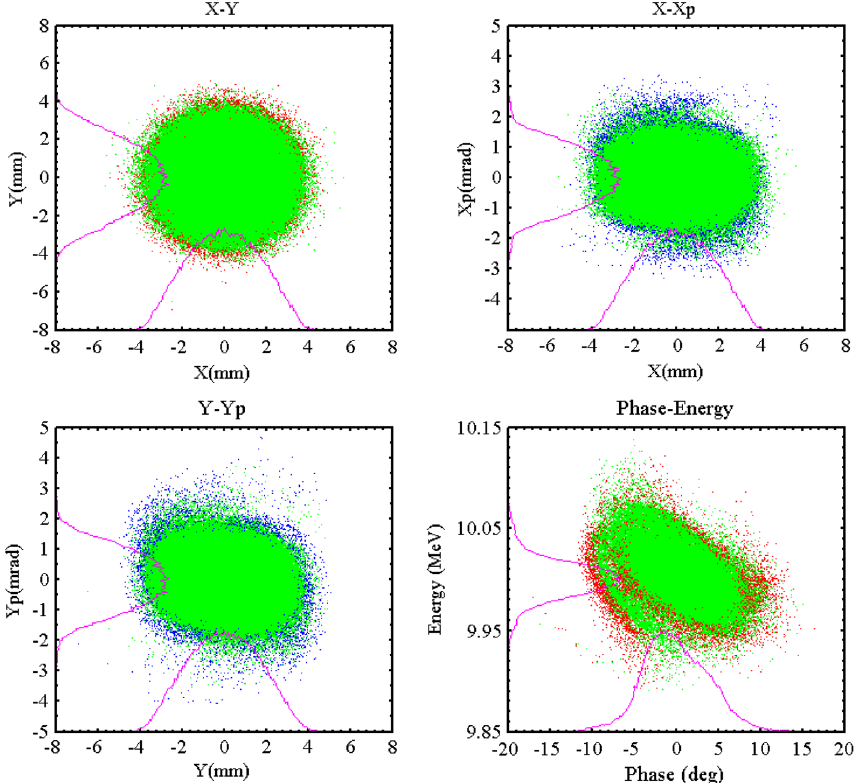
FIG. 18. The benchmarking results for the SC section of Injector I by T RACE W IN and D YNAC : the phase space @ 10